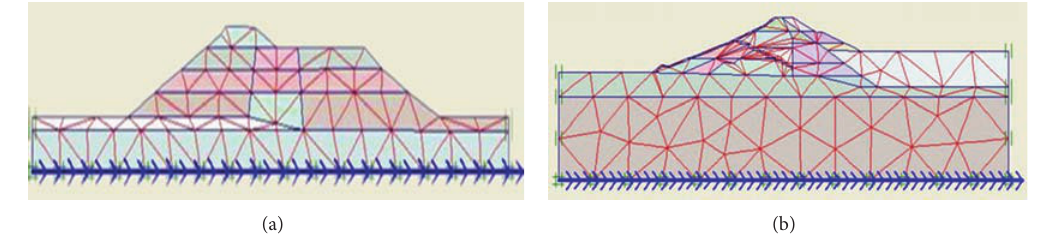
Figure 5: Section of generated mesh of (a) Upper San Fernando and (b) Kitayama dams.